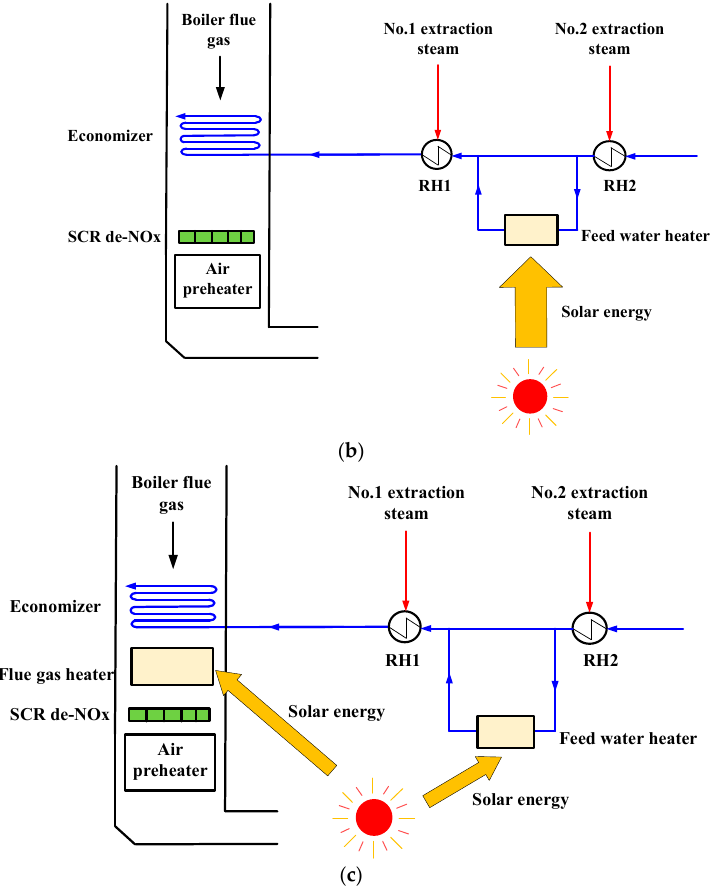
Figure 2. Concept of the proposed SAPG. ( a ) Low load; ( b ) High load; ( c ) Medium load.